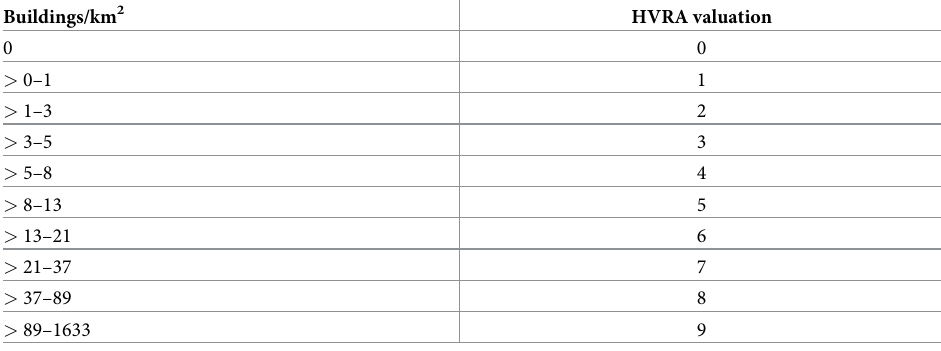
Table 2. Density-based valuation of buildings used for the risk